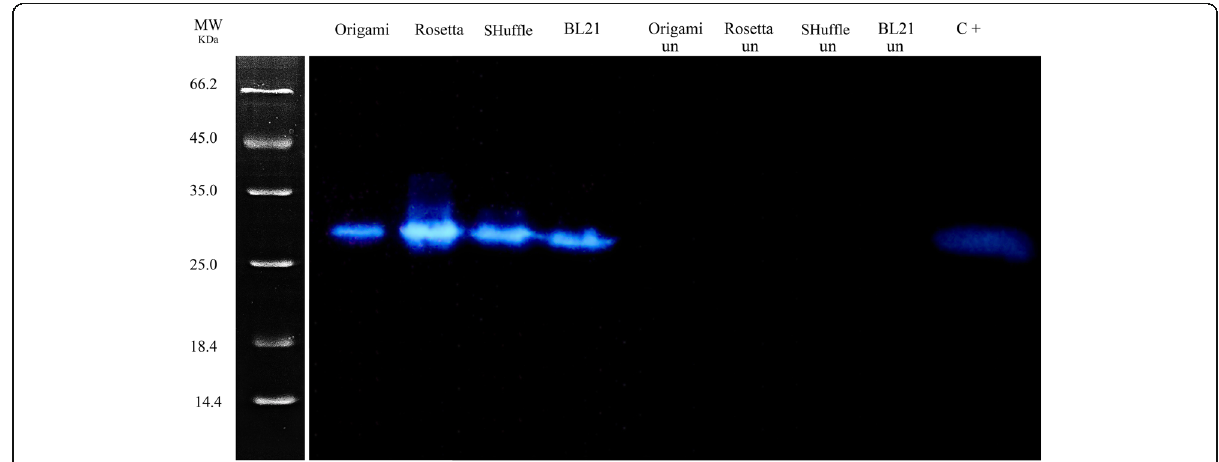
Fig. 2 Western blotting analysis of the recombinant antiEpEX-scFv protein. Bacterial lysates of four E. coli strains including BL21 TM (DE3), SHuffle TM T7, Origami TM (DE3), and Rosetta TM (DE3) before induction (un) and after induction were treated with the anti His tag polyclonal antibody The positive control was E. coli K-12 BW25113 cells harboring the corresponding plasmid and were inducted by 0.8 mM IPTG at 37 °C for 24 h